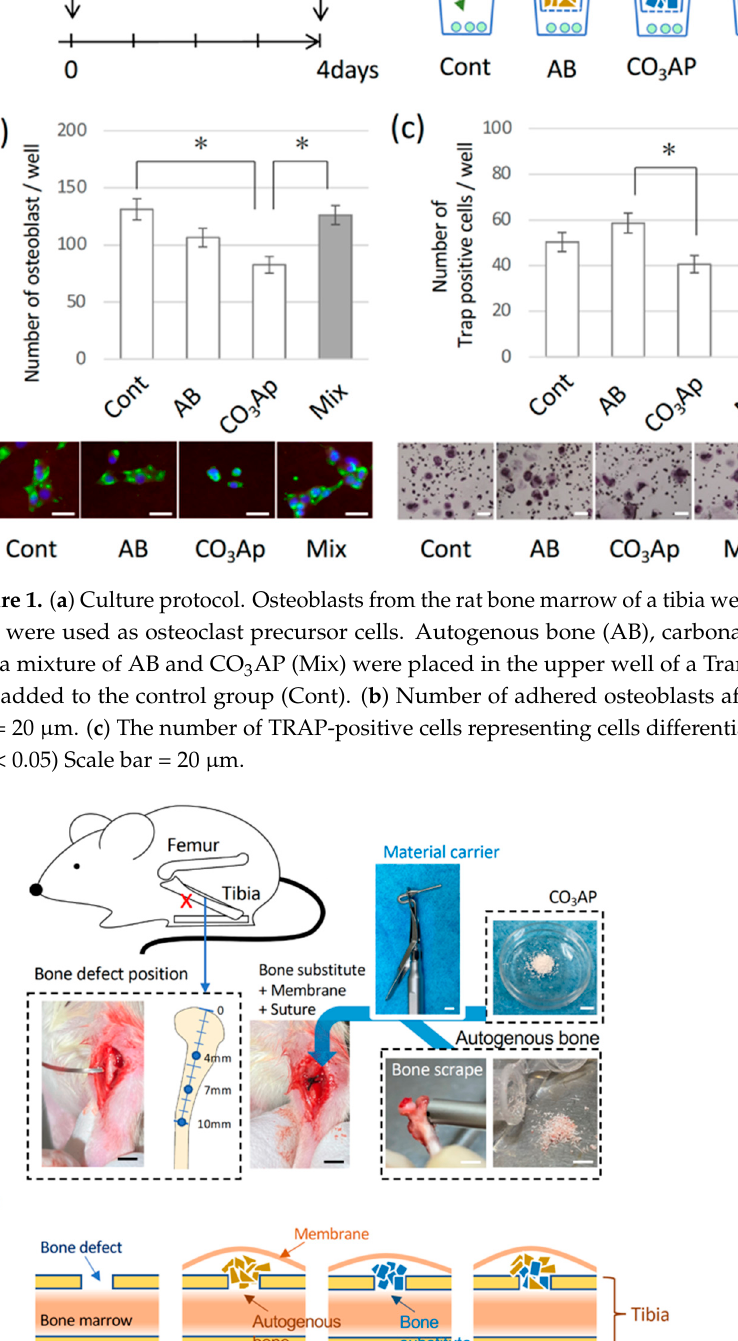
Figure 3. ( a ) Animal protocol. ( b ) Photograph of the morphology immediately after creating a bone defect in the tibia (Day 0). ( c ) Osteogenic process. Hematoxylin and eosin staining after 14 days and 21 days in the control group (Cont), autogenous bone group (AB), carbonate apatite group (CO 3 AP), and AB and CO 3 AP mixed group (Mix). Scale bar = 100 μ m.